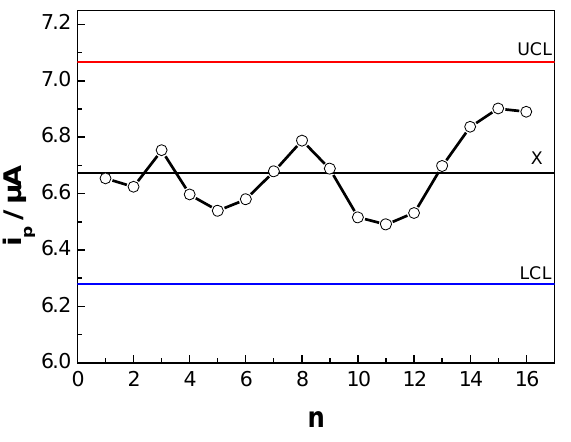
Figure 5. Quality control chart (X - Chart) of 7.5 × 10 -7 M